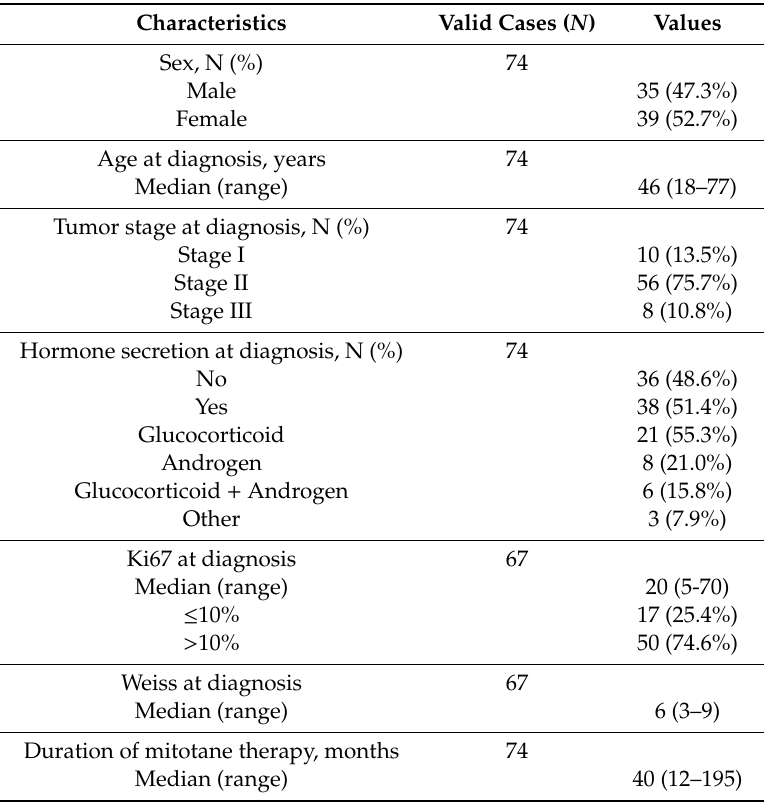
Table 1. Characteristics of